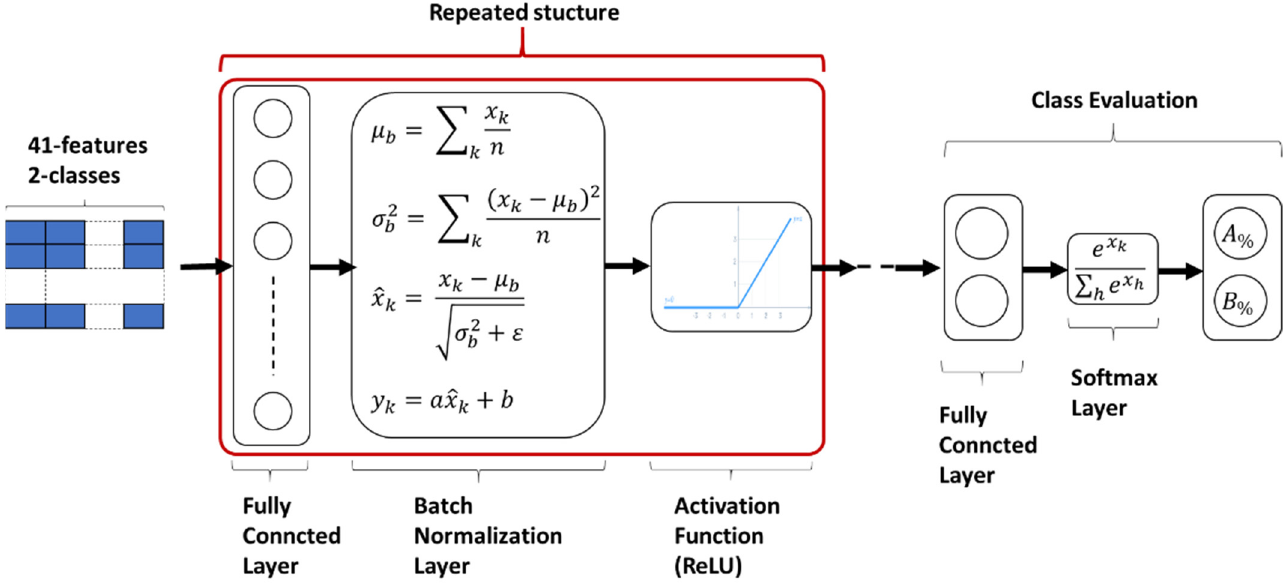
Figure 10. Base architecture of used artificial neural